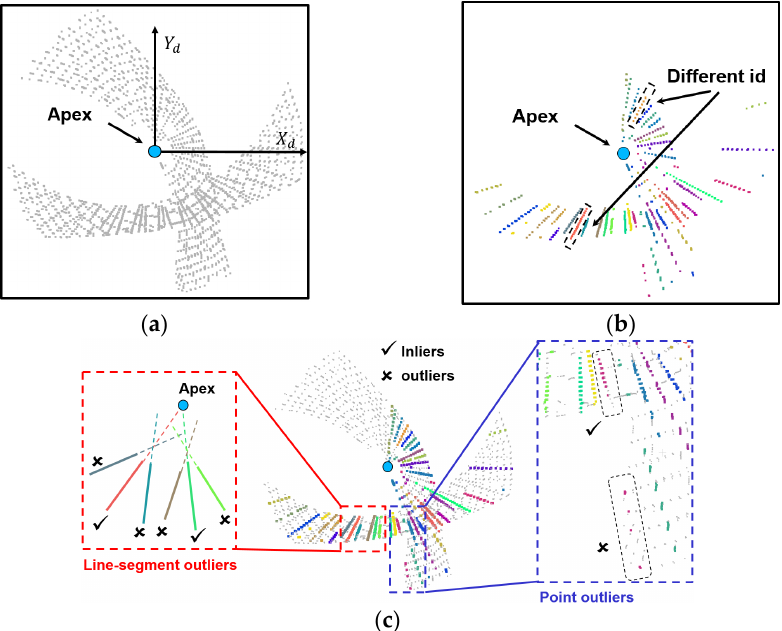
Figure 17. An example of 2D line segment detection results: ( a ) projected edge points, ( b ) detected 2D line segments (colored by id), and ( c ) point and line-segment outliers.